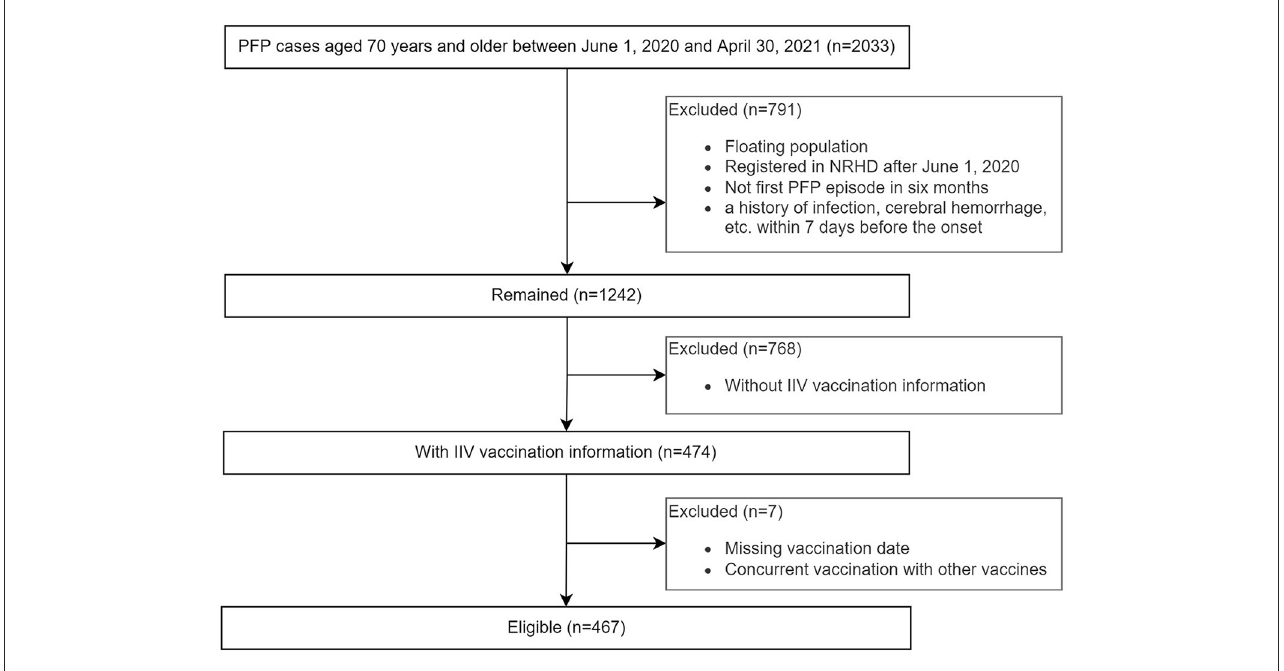
FIGURE1 Flowchart of the study participants.